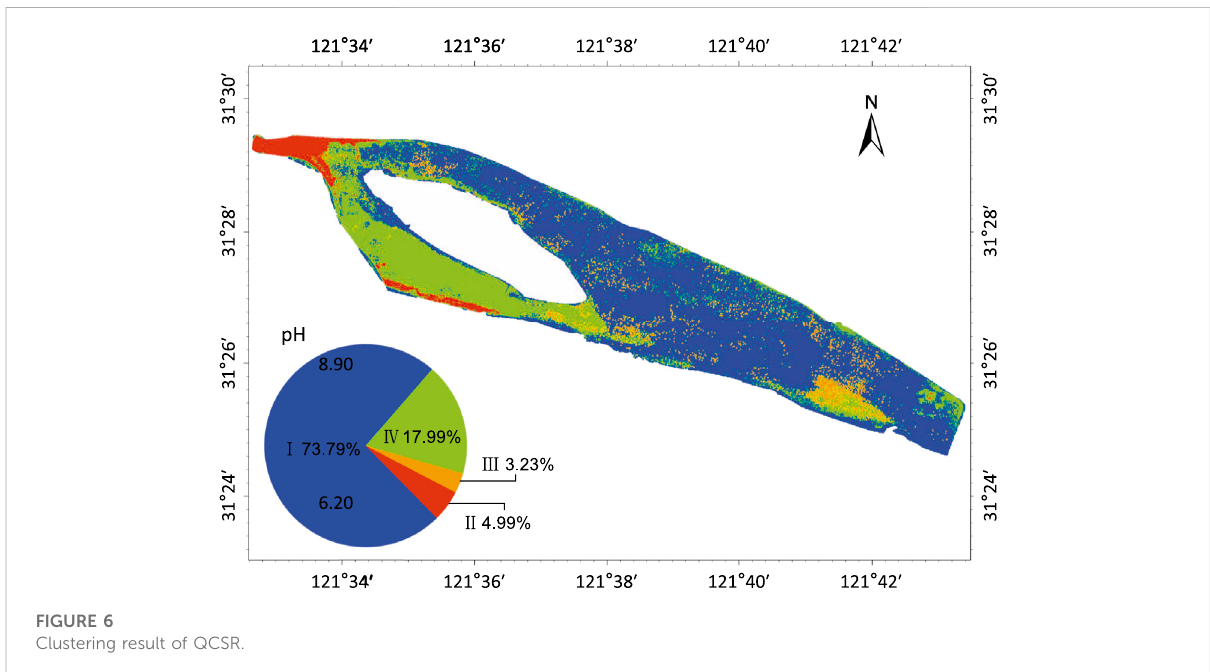
FIGURE 6 Clustering result of